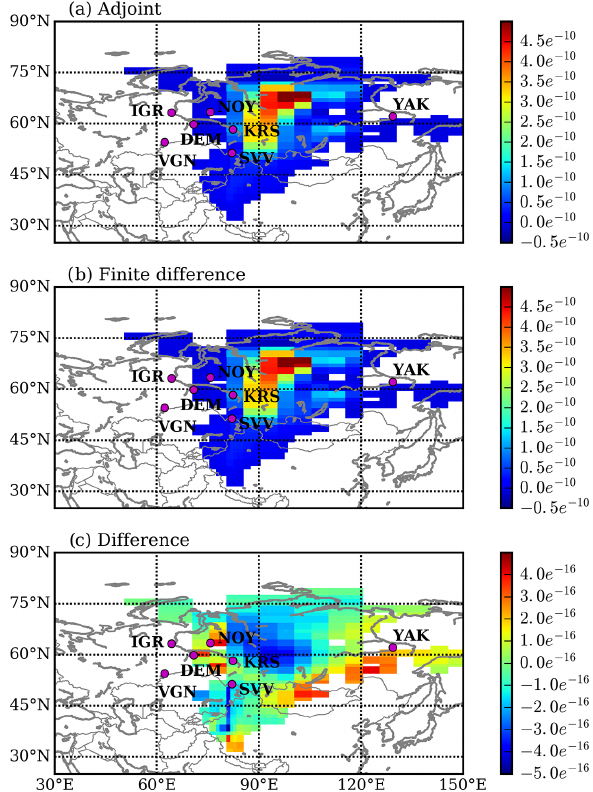
Figure 7. Comparison of sensitivities of CO 2 concentrations (ppm(µmolm − 2 s − 1 ) − 1 ) for test 1: (a) sensitivity calculated con- sidering only the Eulerian adjoint model at a resolution of 2.5 ◦ , (b) the same sensitivity calculated directly from NIES forward runs using the one-sided numerical finite difference method with pertur- bations of ε , and (c) the relative difference between derived adjoint and the numerical finite difference gradients. Magenta dots with la- bels depict the locations and names of the Siberian observation tow-